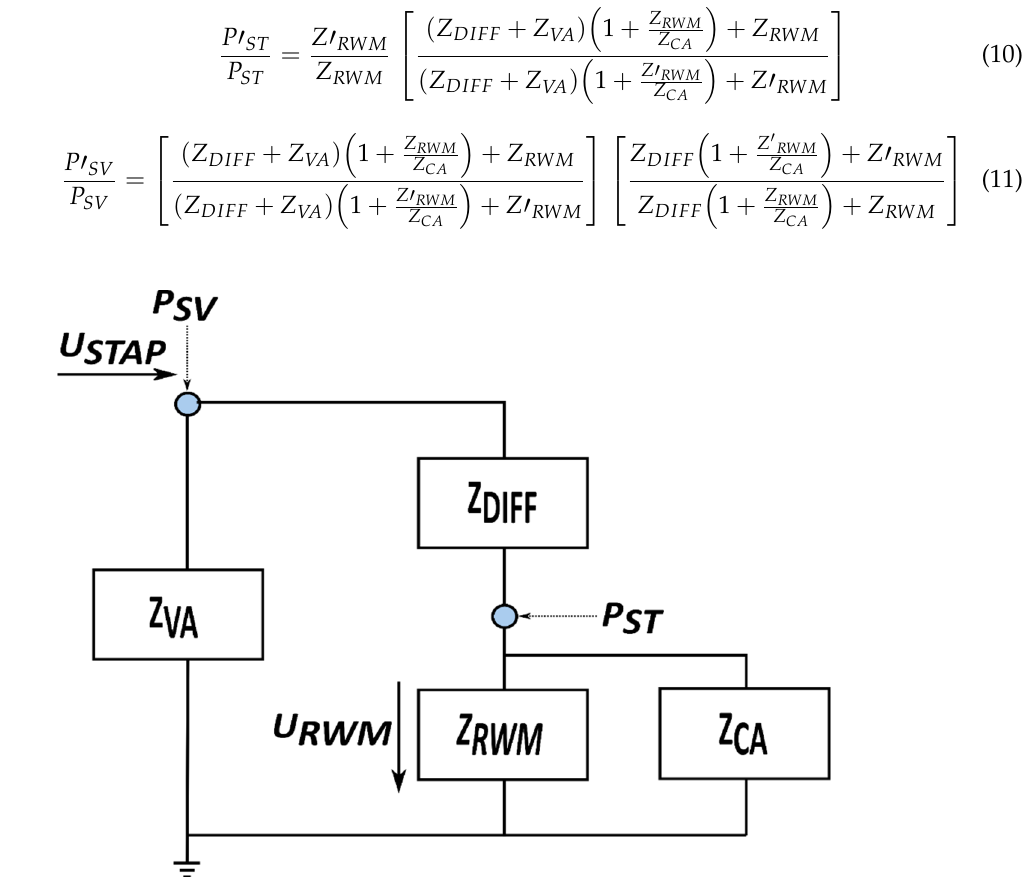
Figure 9. Adapted LEM circuit of the cochlea from Elliot et al. (2016). For descriptive purposes, the individual circuit components describing the four indicated equivalent impedance are not shown.